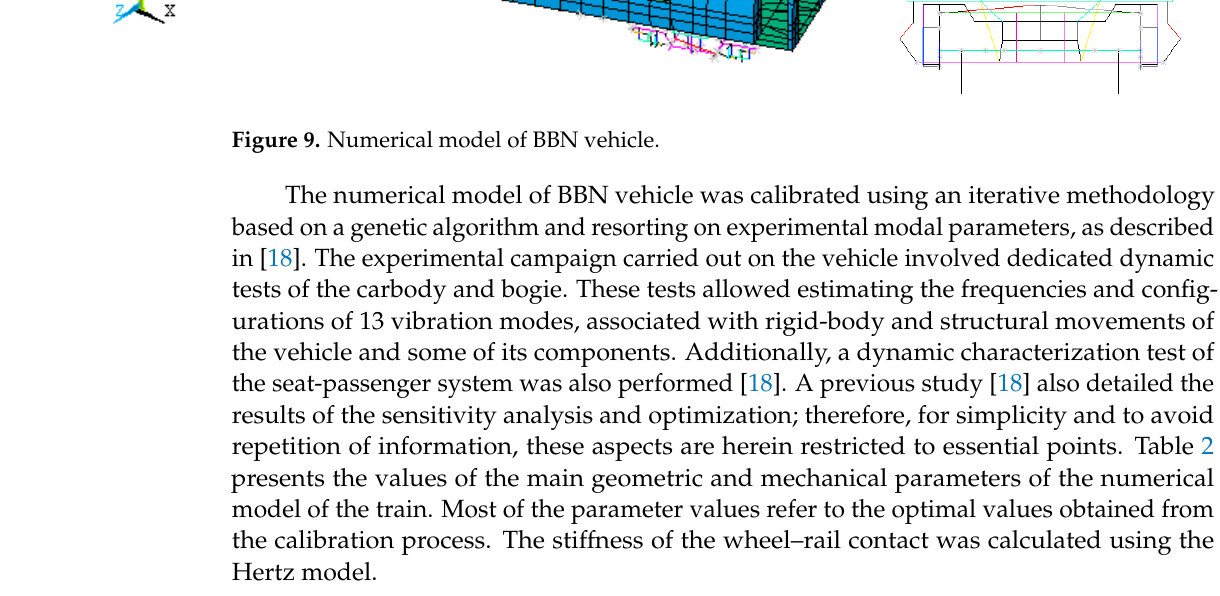
Table 2. Characterization of the main numerical model parameters of the Alfa Pendular train.